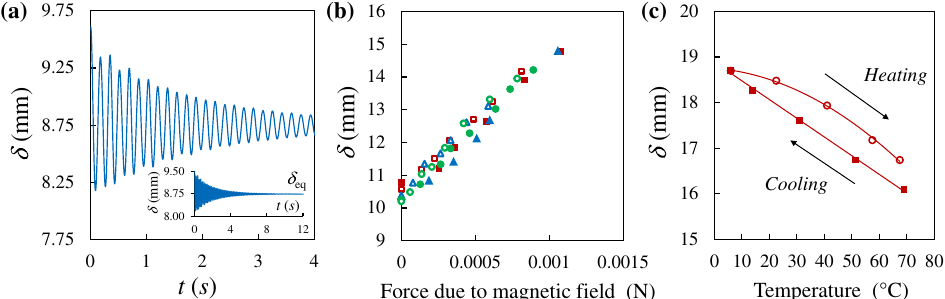
FIG. 2. Experimental evidence of reversibility of the gels. (a) A 10-mm-diameter steel sphere immersed in a 140-Pa gel, when slightly disturbed from its elastobuoyant position via an electromagnet, undergoes underdamped oscillations about its equilibrium depth δ Depth of an elastobuoyant bead (2.8 mm diameter) in a 13-Pa gel is plotted as a function of the strength of an external vertical magnetic force. The depth at zero force indicates the equilibrium-elastobuoyant position of the sphere. The data (red, blue, and green) shown here are from three different experiments, where the closed symbols indicate the loading cycles and the open symbols indicate the unloading cycles. (c) The depth of submersion δ of a 5-mm-diameter steel sphere in a soft gel ( μ ∼ 13 Pa) is shown, varying as a function of its temperature. The experiments in the cooling cycle were performed first, after which the gel was heated systematically to obtain the data for the heating